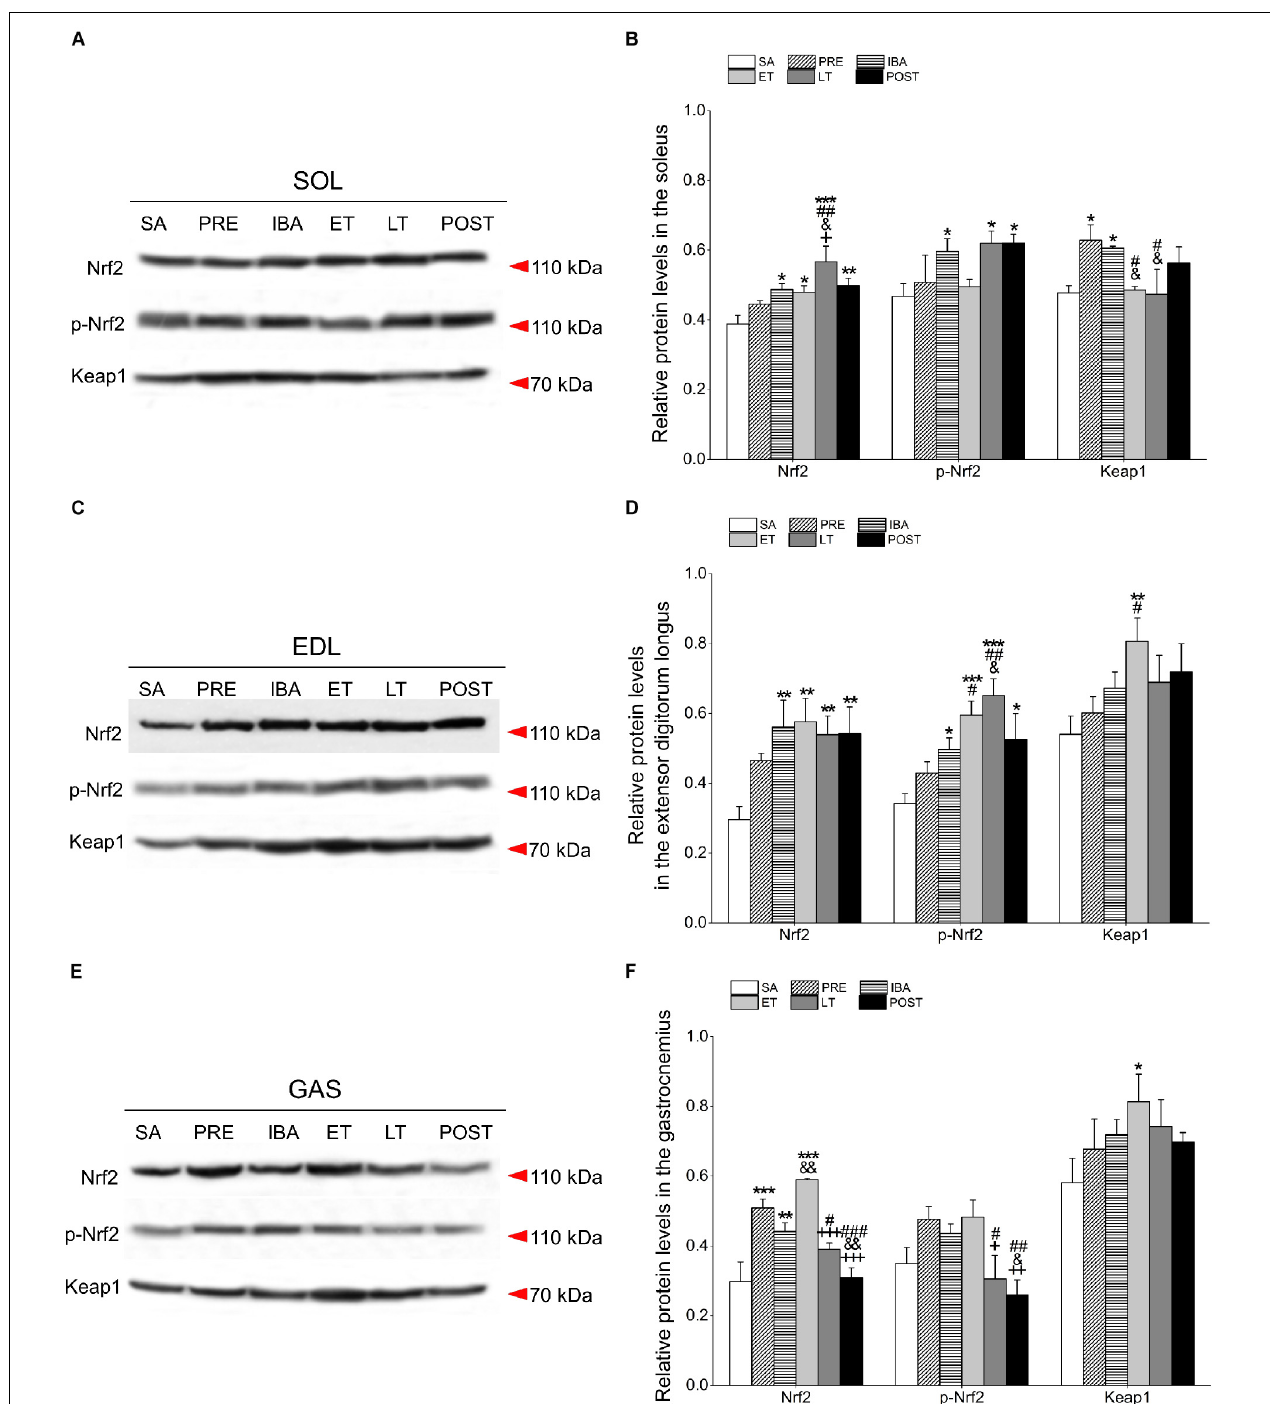
FIGURE 7 | Changes in Nrf2, p-Nrf2, and Keap1 protein levels in different skeletal muscles of Daurian ground squirrels over the torpor-arousal cycle. (A) Representative immunoblots of Nrf2, p-Nrf2, and Keap1 in SOL during six hibernation periods. (B) Relative Nrf2, p-Nrf2, and Keap1 protein expression in SOL. (C) Representative immunoblots of Nrf2, p-Nrf2, and Keap1 in EDL during six hibernation periods. (D) Relative Nrf2, p-Nrf2, and Keap1 protein expression in EDL. (E) Representative immunoblots of Nrf2, p-Nrf2, and Keap1 in GAS during six hibernation periods. (F) Relative Nrf2, p-Nrf2, and Keap1 protein expression in GAS. SA, summer active; PRE, pre-hibernation; IBA, interbout arousal; ET, early torpor; LT, late torpor; POST, post-hibernation. Values are means ± SEM, n = 8. ∗ P < 0.05, Compared with SA; ∗∗ P < 0.01, compared with SA; ∗∗∗ P < 0.01, compared with SA; # P < 0.05, compared with PRE; ## P < 0.01, compared with PRE; ### P < 0.01, compared with PRE; & P < 0.05, compared with IBA; && P < 0.01, compared with IBA; + P < 0.05, compared with ET; ++ P < 0.01, compared with ET; +++ P < 0.001, compared with ET.